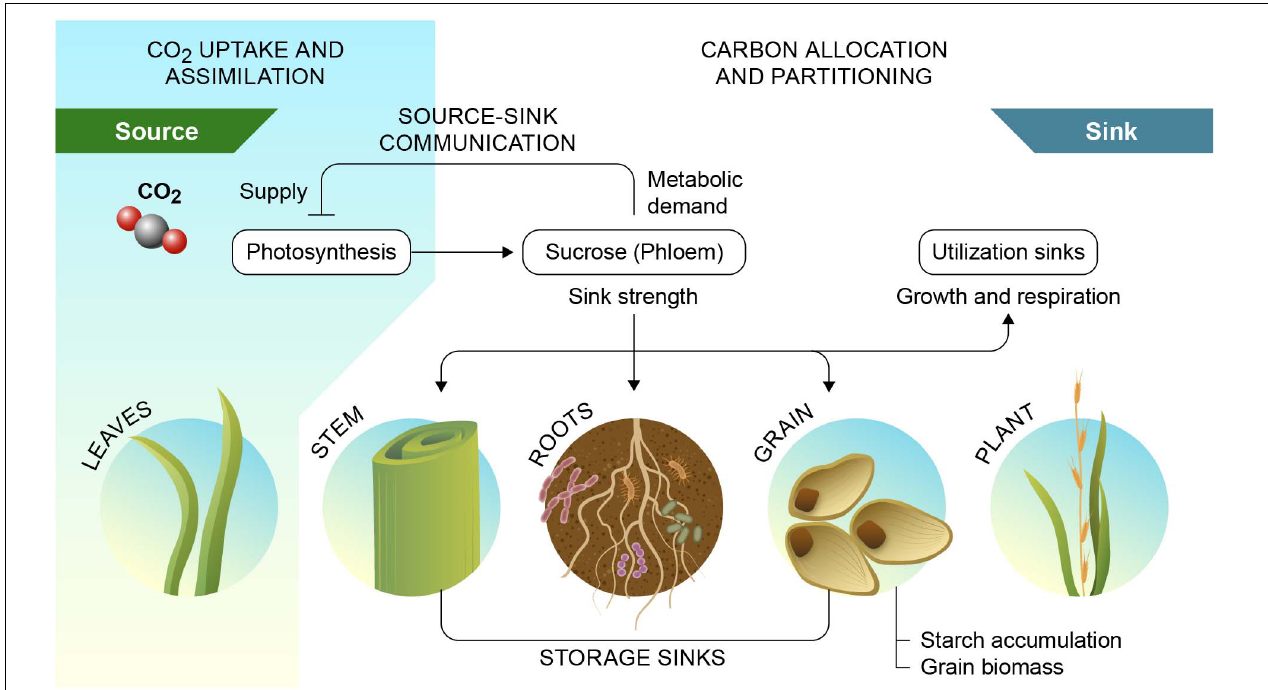
FIGURE 3 | Source–sink interactions of photosynthate production and utilization. Source-sink interactions link carbon sources such as mature leaves to sinks such as roots and seeds and mediates feedback inhibition of photosynthesis via perceived sink demand. Sink strength of the rhizosphere is contributed by the root biomass and associated microbial communities, including arbuscular mycorrhiza. Reprinted from Fan et al.